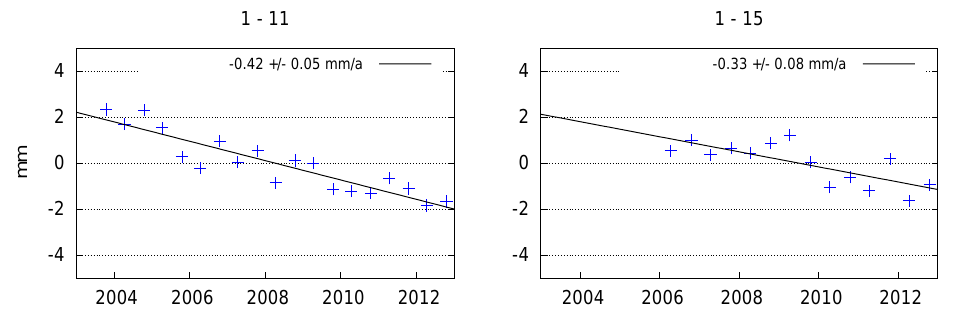
Figure 7. Deviation of baseline length time series for the outer